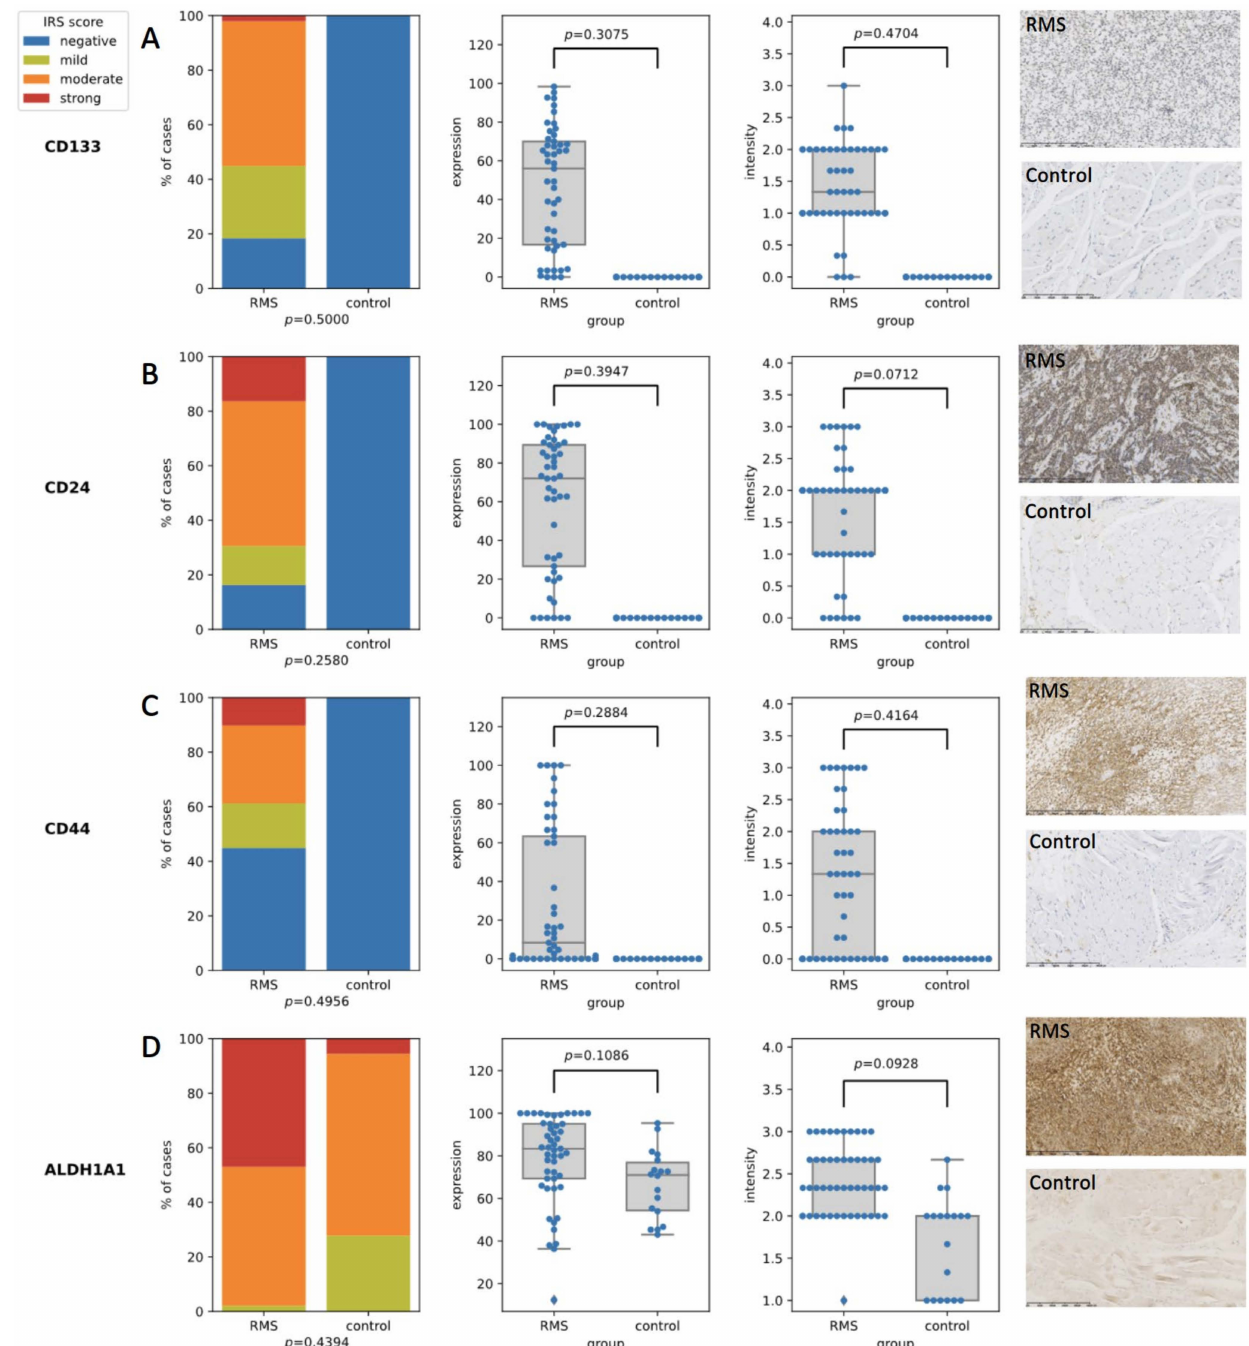
Figure 1. The expression of the stem cell markers in the RMS and normal muscles. ( A ) The expression of the CD133 middle panels—comparison between RMS cases and controls in terms of expression and intensity, right panel—the IHC staining of RMS case (upper panel) and control (lower panel) sample; ( B ) The expression of the CD24 middle panels—comparison between RMS cases and controls in terms of expression and intensity, right panel—the IHC staining of RMS case (upper panel) and control (lower panel) sample; ( C ) the expression of the CD44 middle panels—comparison between RMS cases and controls in terms of expression and intensity, right panel—the IHC staining of RMS case (upper panel) and control (lower panel) sample; ( D ) The expression of ALDH1A1 middle panels— comparison between RMS cases and controls in terms of expression and intensity, right panel—the IHC staining of RMS case (upper panel) and control (lower panel)